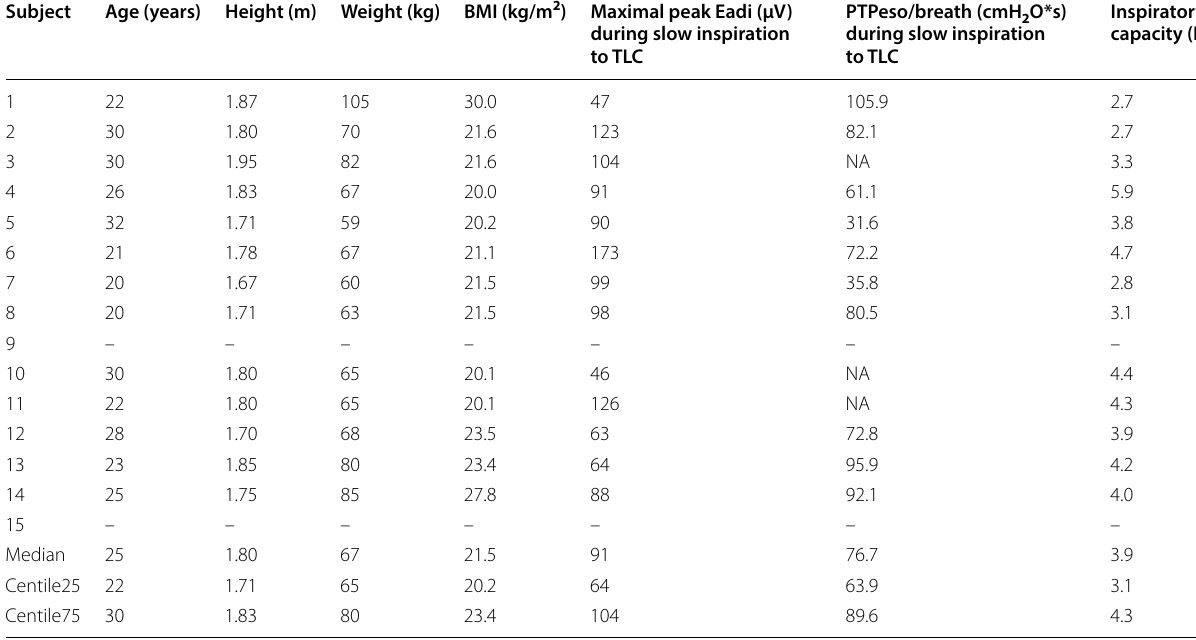
BMI body mass index, Eadi electrical activity of the diaphragm, PTPeso esophageal pressure–time product, NA not available